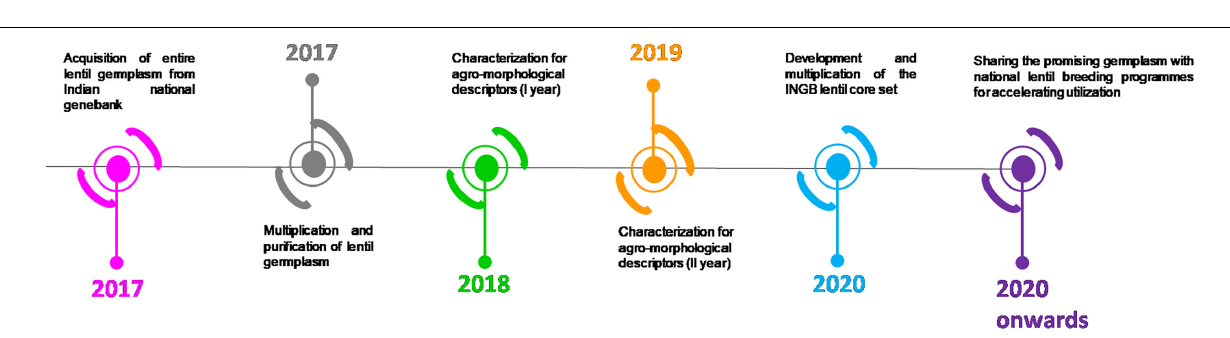
FIGURE 2 | Timeline of the present investigation from 2017 until